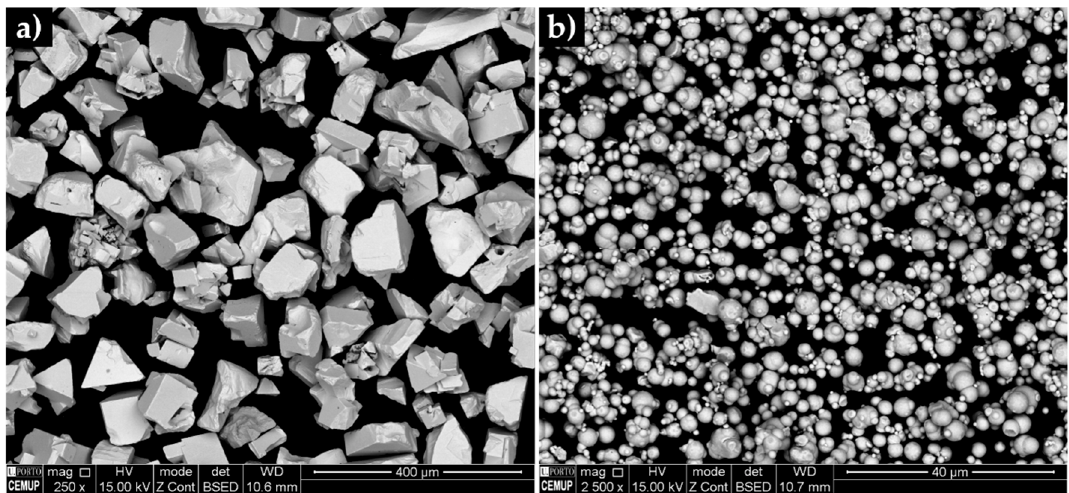
Figure 3. SEM-backscattered electron (BSE) images of the initial powders: ( a ) WC with polyhedral morphology and ( b ) round particles of Fe.